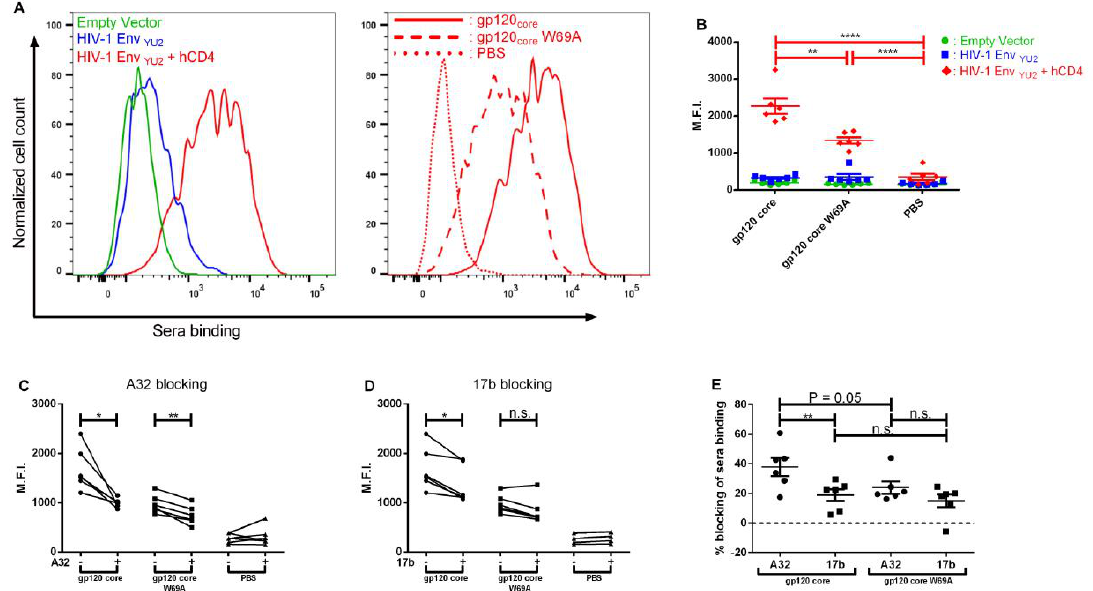
Figure 3. Elicited anti-gp120 antibodies recognize the “open” CD4-bound Env conformation. Cell-surface staining of HEK293T cells either mock-transfected or transfected with an HIV-1 YU2 Env expressor in combination with a CD4 expressor or not. ( A ) Shown are histograms depicting representativestainingobtainedwith1gp120 core immunizedanimalserumonHEK293Tcellstransfected with an empty vector and an HIV-1 YU2 Env expressor in combination or not with a CD4 expressor and staining with a representative serum of each group on HEK293T transfected cells with an HIV-1 YU2 Env and CD4 expressor. ( B ) Cells were stained with immunized guinea pig sera (1:500 dilution) followed by anti-guinea pig secondary antibody